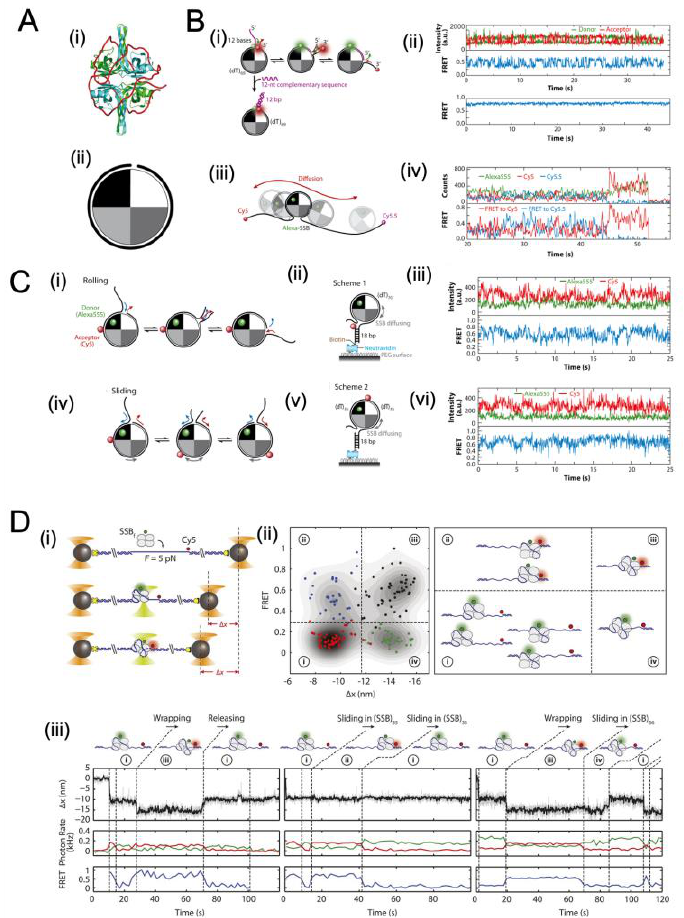
Figure 4. Single-molecule observations of SSB diffusion along ssDNA. ( A ) depicts an SSB tetramer bound to 65 nt of ssDNA based on a crystal structure [97] PDB ID of 1EYG. ( B ) demonstrates the diffusion of SSB along ssDNA using smFRET experiments. The results show rapid fluctuations in the FRET state due to SSB diffusion on 81-nt ssDNA (ii, top) but a reduction in fluctuations when ssDNA is limited to 69 nt (ii, bottom). The three-colour smFRET method was also used to demonstrate SSB diffusion along (dT) 130 ssDNA(iii-iv). Images adapted from [67]. ( C ) depicts two hypotheses of SSB diffusion, the rolling and sliding mechanisms, with the latter being supported by single-molecule time traces. The results showed the same level of fluctuations in the donor and acceptor intensities regardless of the position of the acceptor on the DNA, suggesting the entire ssDNA sequence moves relative to the SSB protein surface. Reprinted with permission from Ref. [33]. Copyright 2011 Elsevier. ( D ) shows the binding modes and diffusion mechanism of SSBs, as measured by simultaneous fluorescence and DNA extension change, which provide information about SSB wrapping states and dynamics. Images adapted from Figure 4 of [16] under a Creative Commons Attribution 4.0 International